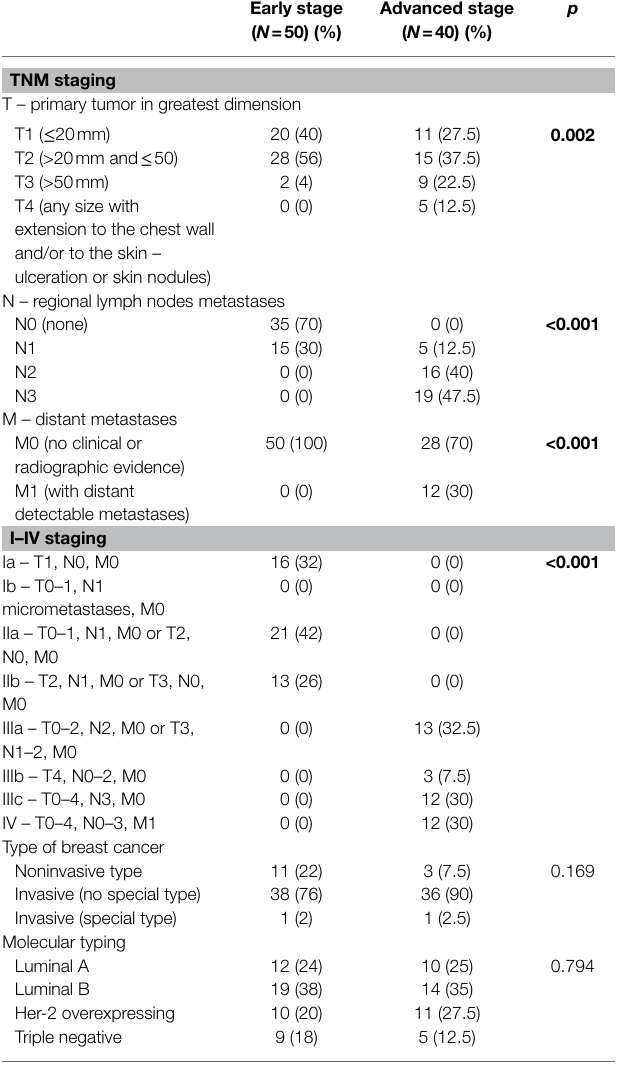
TABLE 2 | Clinical characteristics of breast cancer (BC) patients. TABLE 3 | Comparison of HRV parameters among the benign, early-stage, and